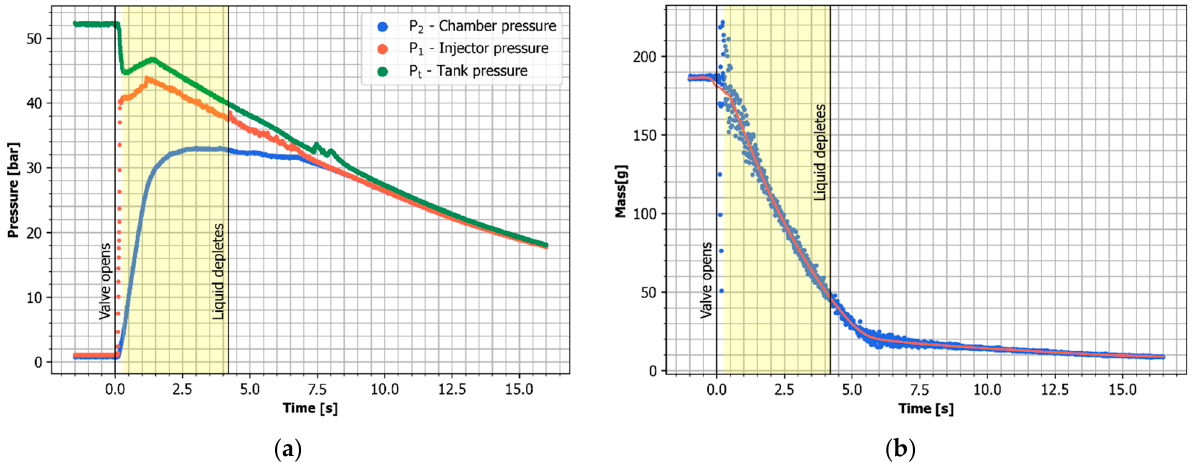
Figure 6. Data trimming for a typical test: ( a ) pressure time history, ( b ) run tank mass time history. Data for the Injector No. 2.